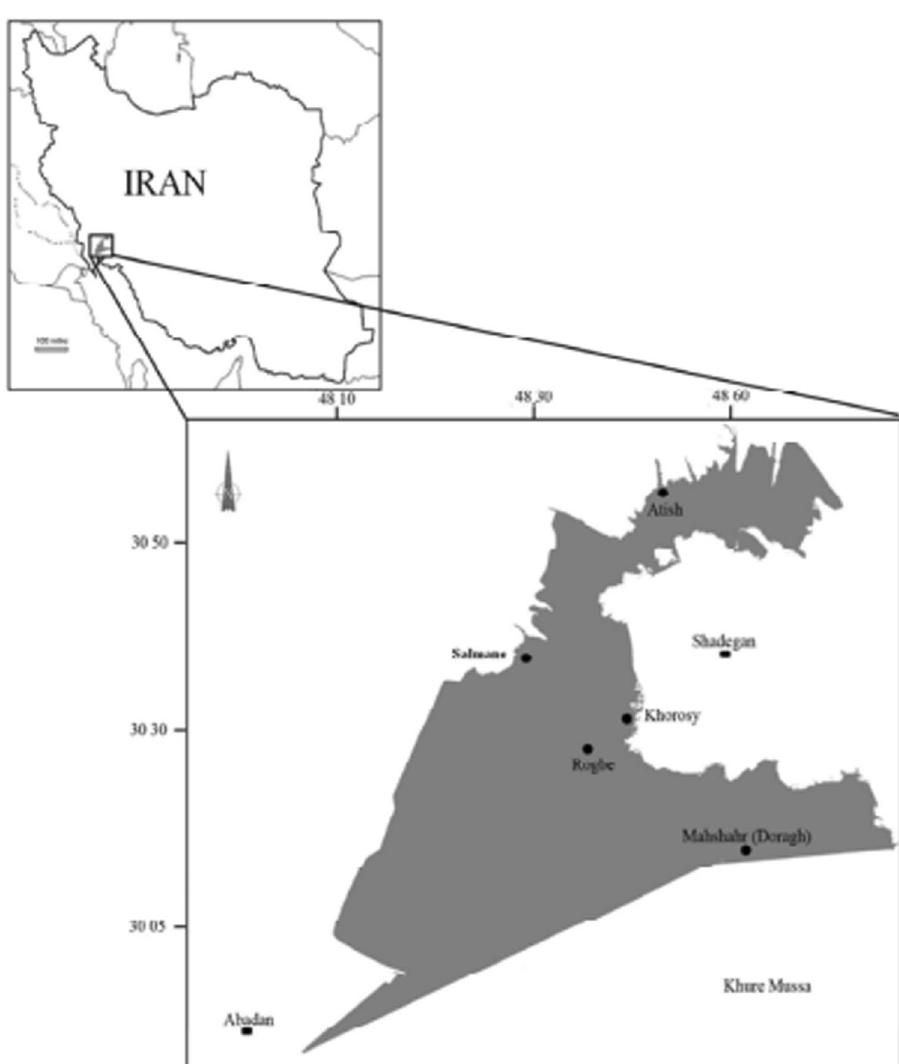
Fig. 8 The plan of Iran, Posi- tion of Seven Apprehension locations was experimented in Shadegan wetland (Khuzestan Province, South West of